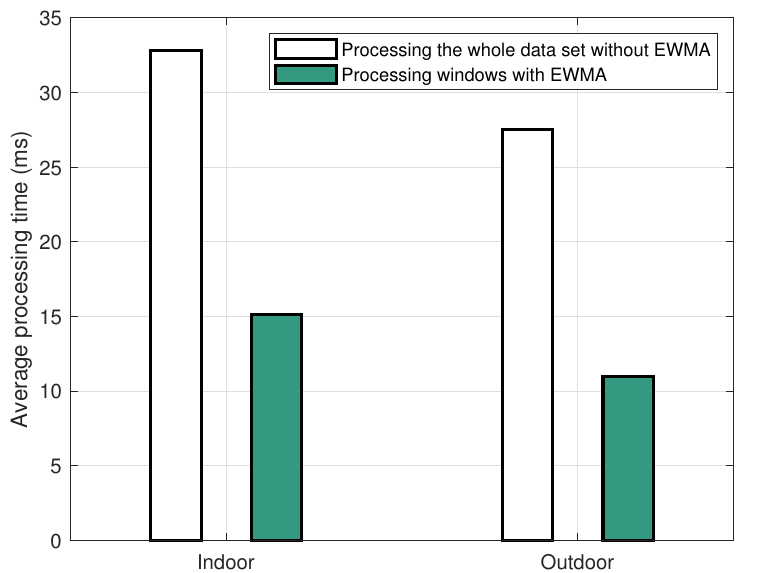
Figure 15. Comparison of the average processing time in the cases with and without the EWMA, for indoor and outdoor walking